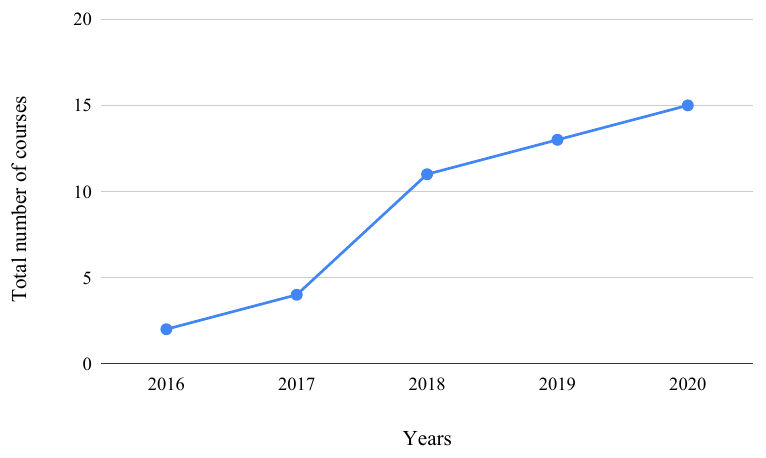
Figure 8. A trend of the number of blockchain courses in Thailand from 2016 to